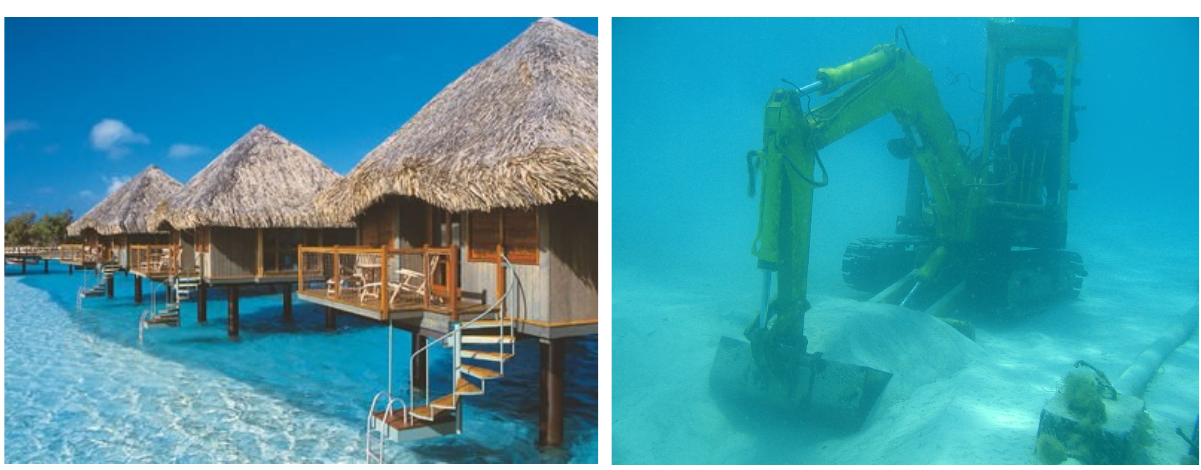
Figure 6. View of “motus” and the construction of the distribution